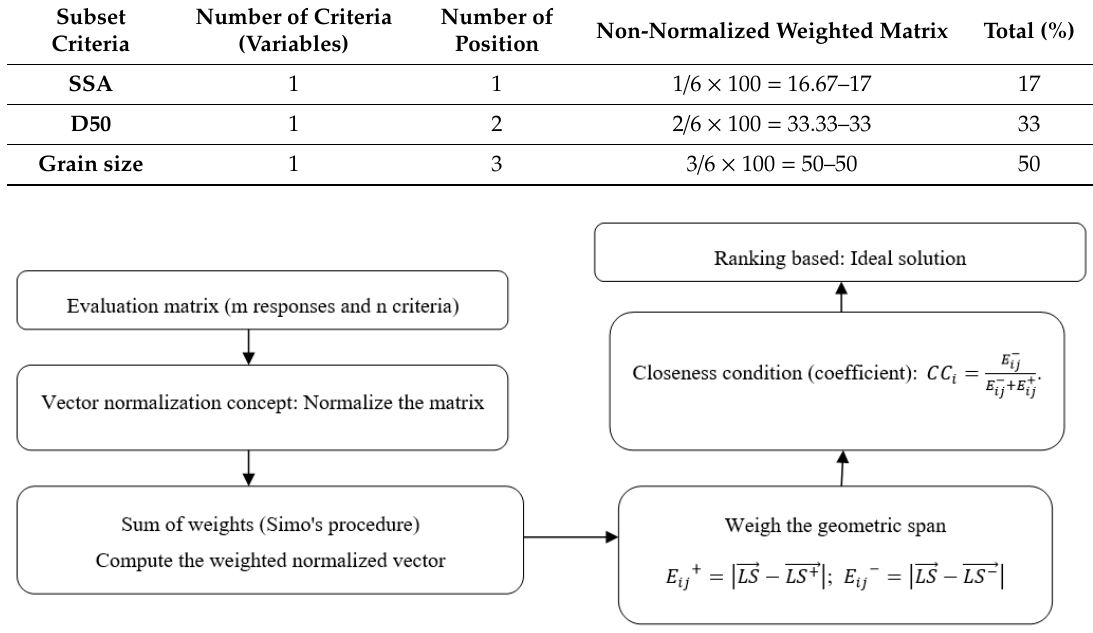
Table 4. Computational steps of SIMOS weighting procedure for ball milling.